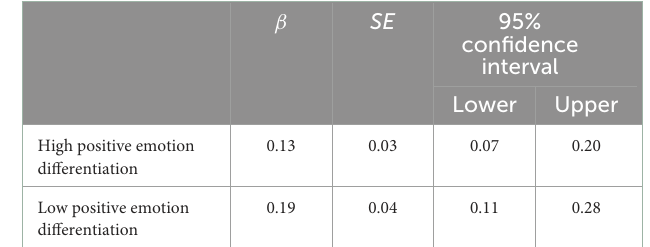
TABLE 5 Moderating effect of different positive emotion